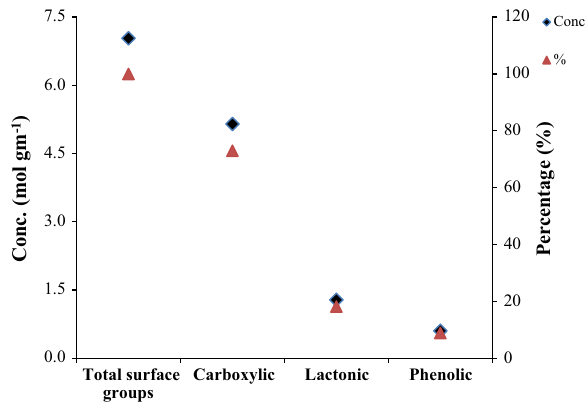
Fig. 4 Surface acidic groups concentration (mol g −1 ) of bagasse bio- char